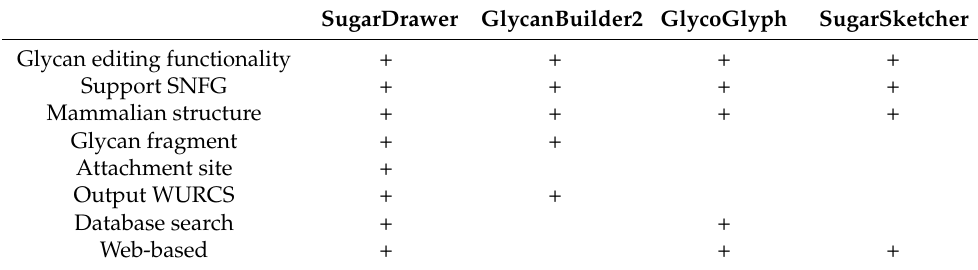
Table 1. Summary of features of glycan visualization